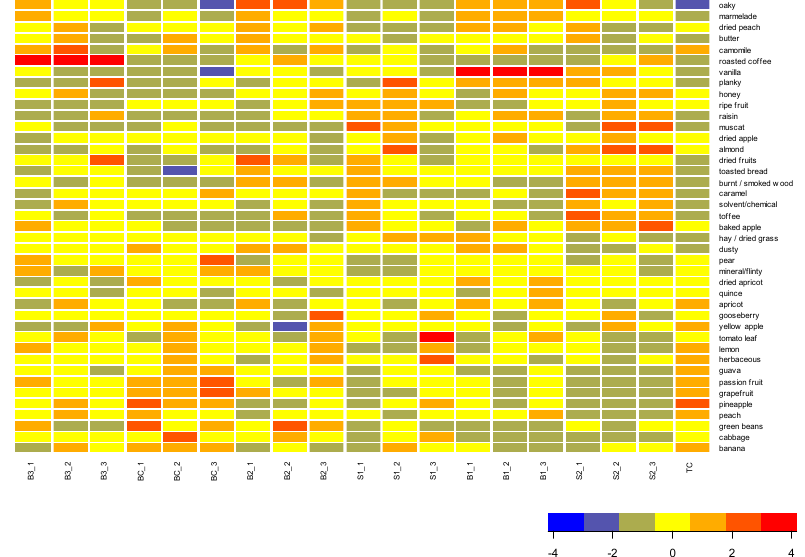
Figure A4. Heat maps constructed based on the standardized residuals that were generated by the correspondence analyses of individual repeats obtained with the trained panel ( n = 20) after 6 months of bottle ageing. The more negative (i.e., the more “blue” on the heatmap) the residuals, the more indication that the correspondence (co-occurrence) between the items are less than what would be expected under the assumption of complete random occurrence. And vice versa, the more positive (i.e., the more red on the heatmap) the residuals, the more indication that the co-occurrence are more that expected under complete random occurrence. TC: Tank control, BC: Barrel control, B: New barrel treatments, S: Stave